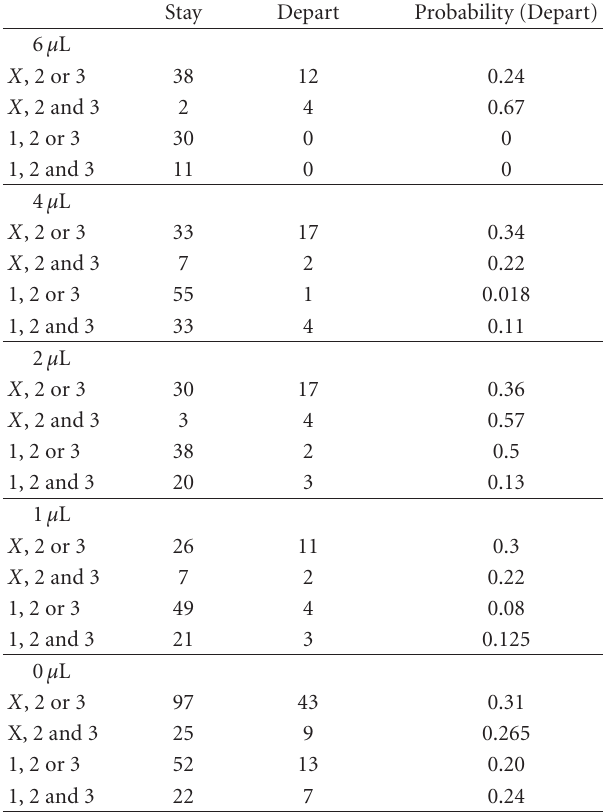
Table 9: Departure patterns of bumble bees on treated inflo- rescences of Aconitum columbianum. The experiment used a descending series of volumes of 30% sucrose solution, from 6 to 0 microliters, in bottom flowers of the inflorescence, with second- from-bottom and third-from-bottom flowers empty. The notation for visit patterns is as detailed in Table 8. Three-way log-likelihood test of independence, G = 28.085, P < . 01 for the 3-way interaction.